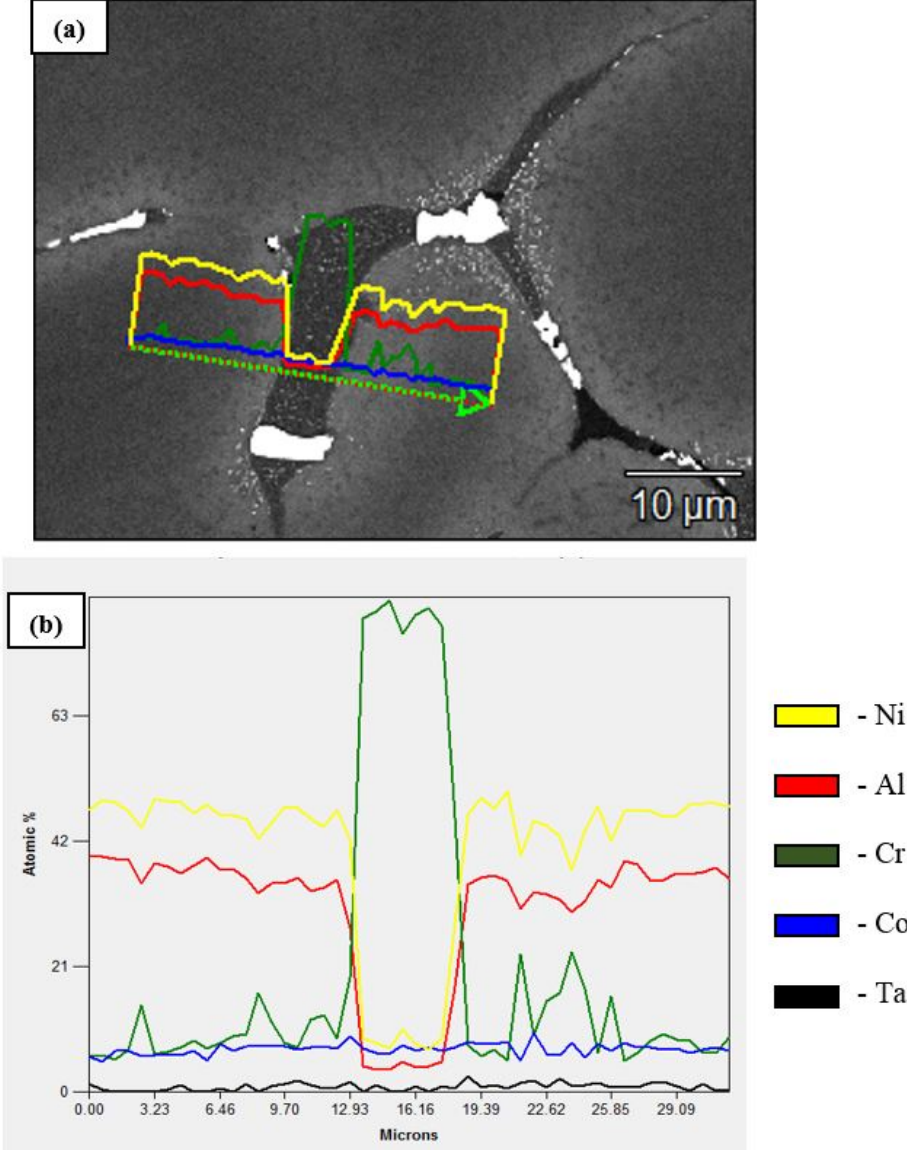
Figure 8. The microstructure of the alloy doped with tantalum ( a ) and the profile of element distribution in the intergrain space ( b ).